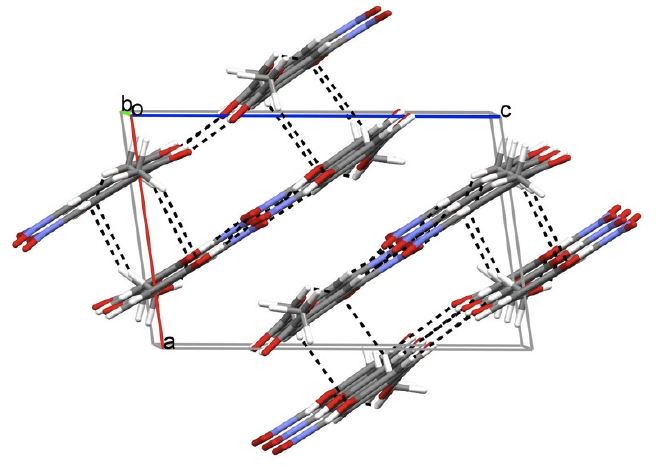
Figure 4. Crystal packing for (I) viewed along the b axis with hydrogen bonds drawn as dashed